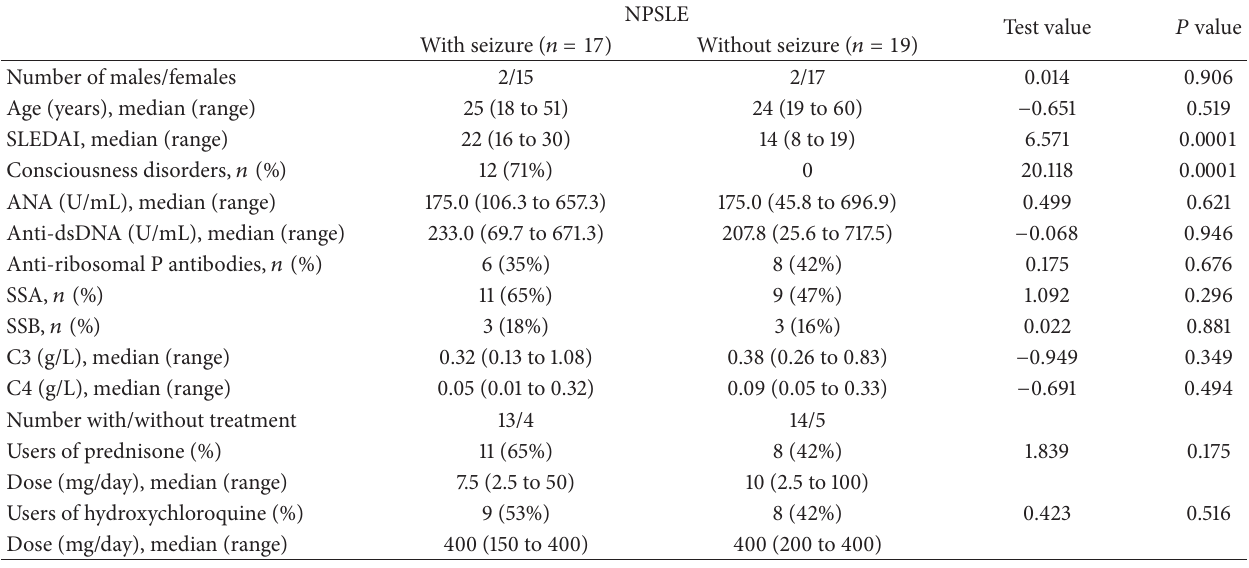
Table 3: Comparison of clinical characteristics between patients with seizure and without seizure in NPSLE group.